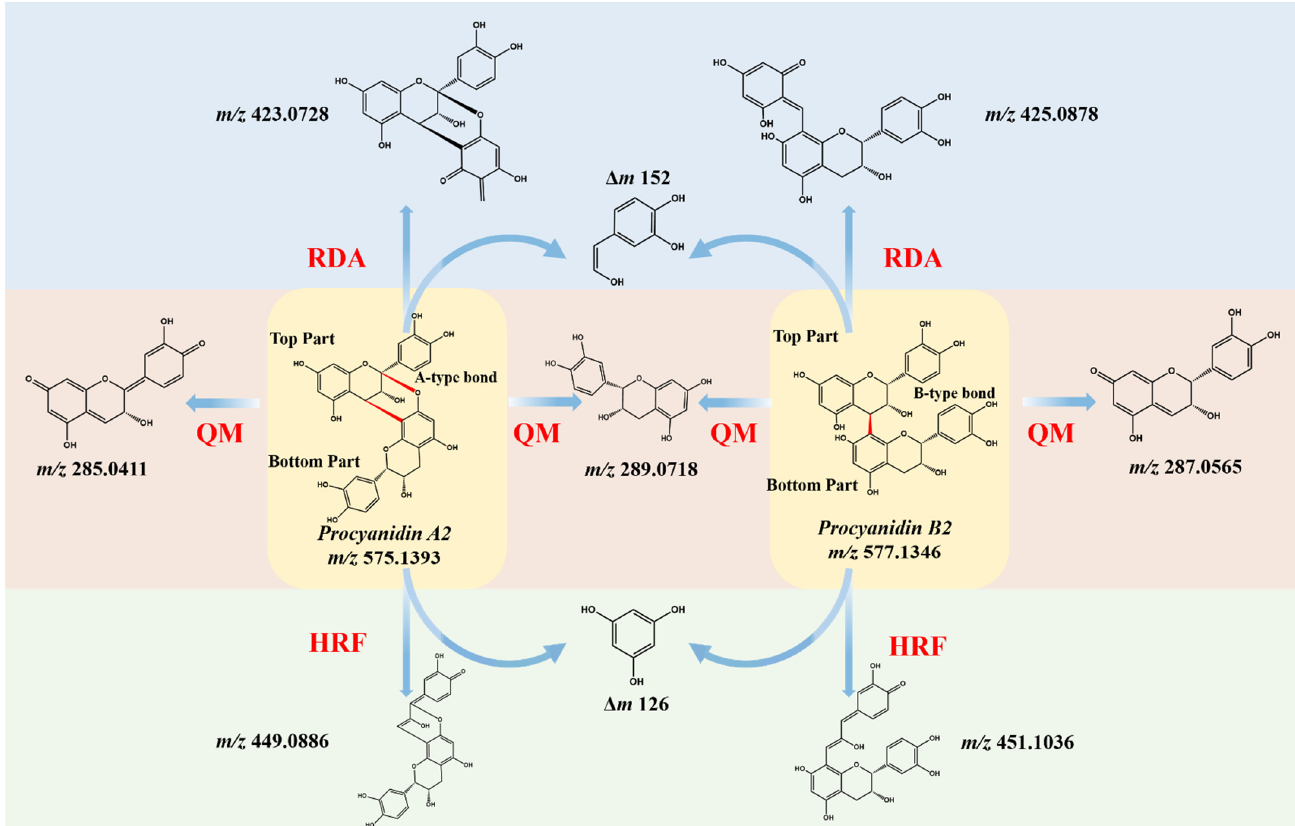
Figure 1. The main fragmentation pathways of Procyanidin dimers with A-type (Procyanidin A2) and B-type (Procyanidin B2) linkages (QM: quinone methide fission, HRF: heterocyclic ring fission; RDA: